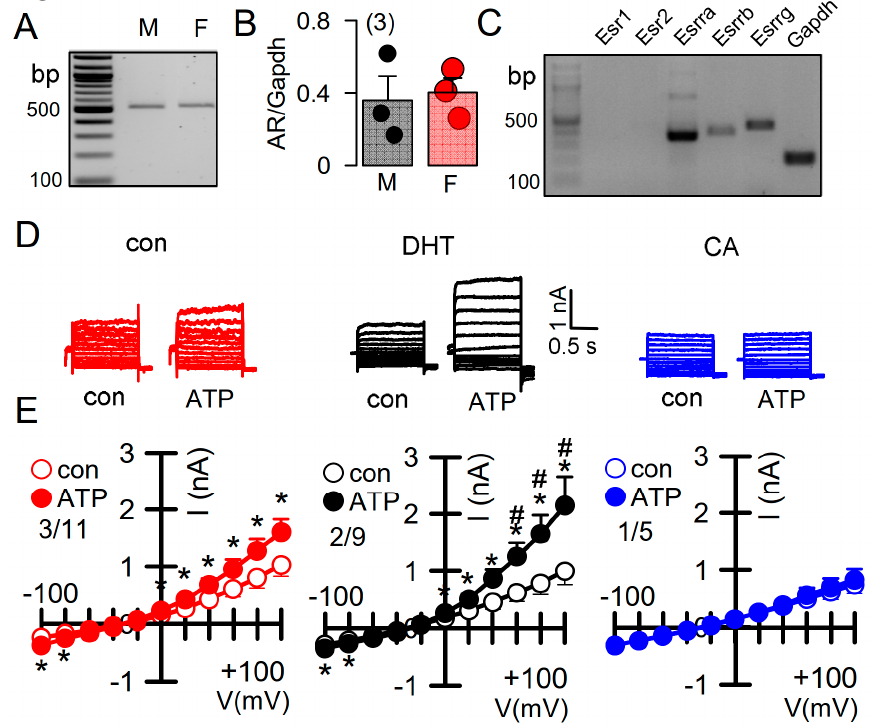
Figure 5. Effect of dihydrotestosterone on whole cell currents in primary renal epithelial cells from female Pkd1 +/+ mice. ( A , B ) RT-PCR analysis of expression of the androgen receptor (AR) in primary renal epithelial cells from male and female kidneys. ( C ) Expression of estrogen receptors in primary renal epithelial cells from female Pkd1 +/+ mice. ( D , E ) Whole cell current overlays and corresponding I/V-curves from primary renal epithelial cells of female Pkd1 +/+ mice. ATP (50 µ M) -activated currents were augmented in cells-incubated with dihydrotestosterone (DHT; 10 µ M, 24 h), but were absent in cyproterone acetate (CA, 10 µ M, 24 h) incubated cells. Mean ± SEM (number of animals/number of experiments in each series). * Significant activation by ATP ( p < 0.05; paired t-test). # Significant difference when compared to con (no DHT) ( p < 0.05; ANOVA and Tukey’s post-hoc test).